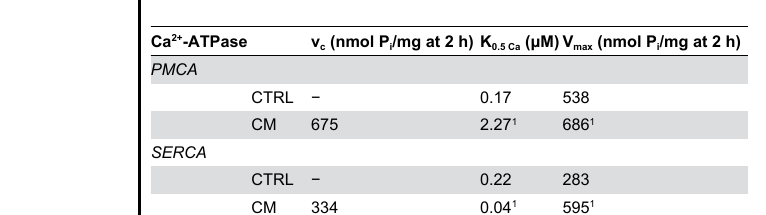
Table 3. Kinetic parameters: Ca 2+ concentration dependence of PMCA and SERCA from CTRL and CM preparations of vas deferens (n = 5).